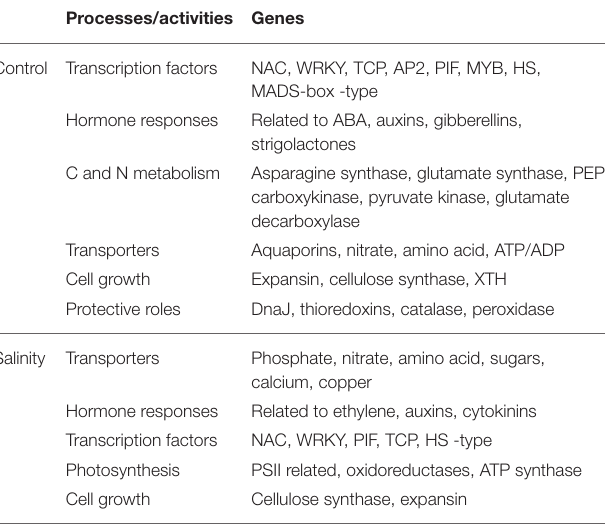
TABLE 2 | Summary of representative up-regulated genes in the transgenic 35S::AtCDF3 (L 2.3) tomato plants under control and salinity conditions.